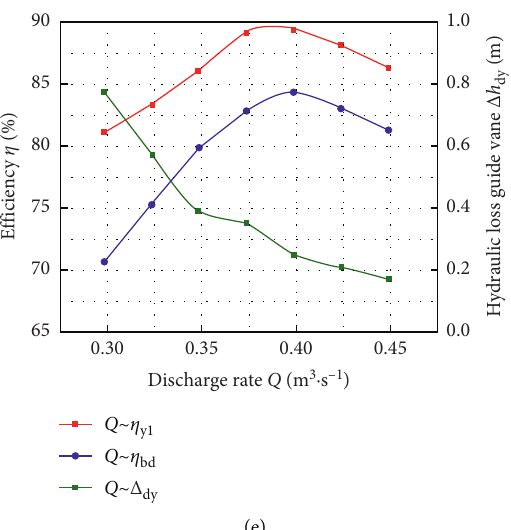
Figure 18: Influence of Δ h